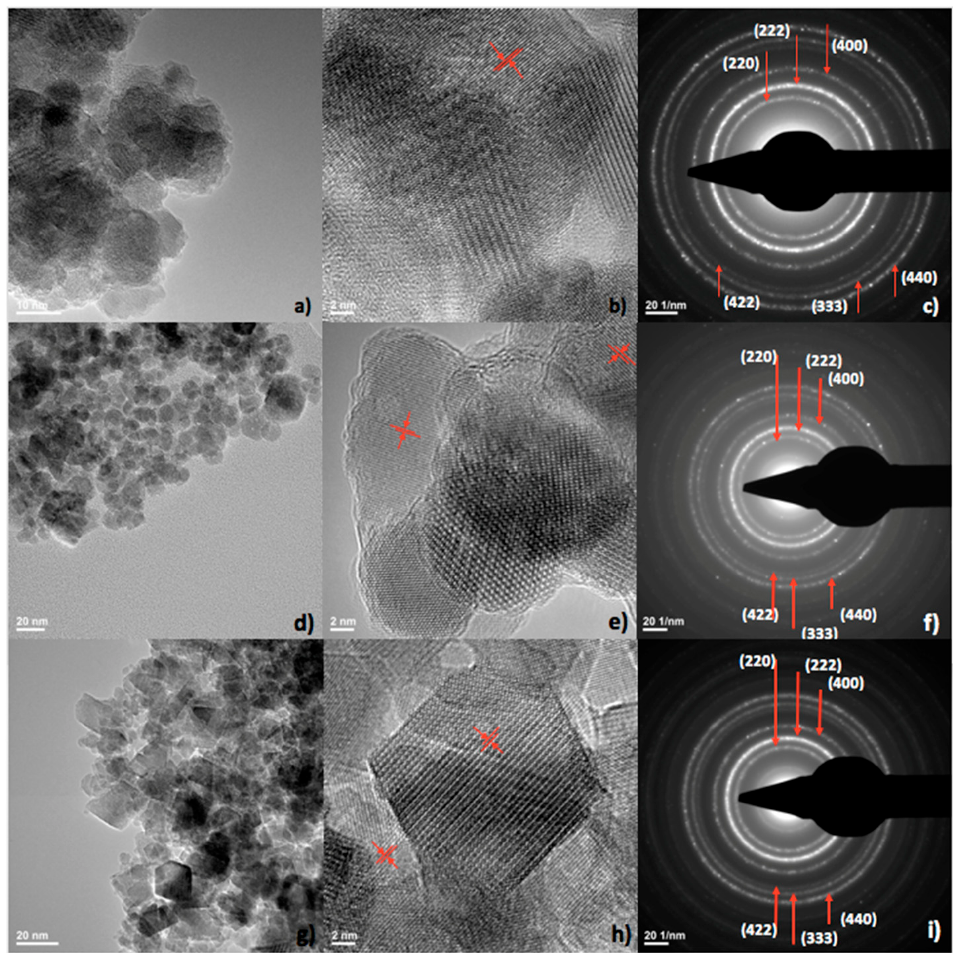
Figure 1. Transmission electron microscopy (TEM) images ( a , d , g ), high resolution TEM (HR-TEM) ( b , e , h ), respectively, selected area electron diffraction (SAED) spectrums ( c , f , i ) for Fe 3 O 4 ( a – c ), Fe 3 O 4 @PEG 20 K ( d – f ) and Fe 3 O 4 @PEG 35 K ( g – i ). Red arrows in ( b , e , h ) indicate (220) crystalline plane. Fe 3 O 4 , Fe 3 O 4 @PEG 20 K, and Fe 3 O 4 @PEG 35 K NPs were intravenously